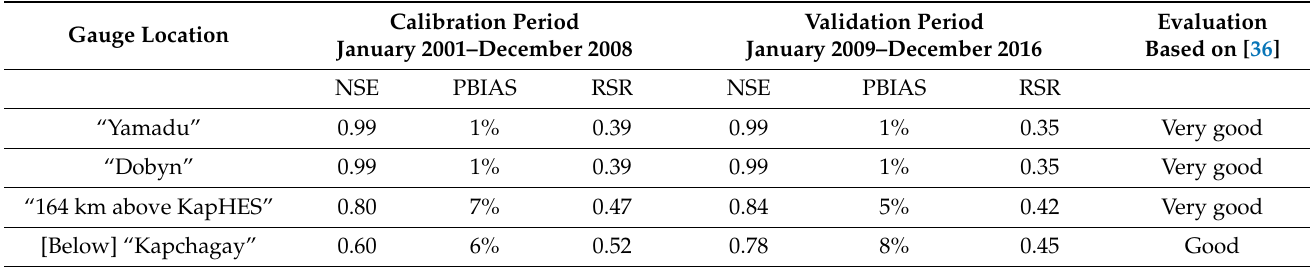
Table 2. Calibration and validation results for the Ili basin model in the RiverWare platform. Gauge Location